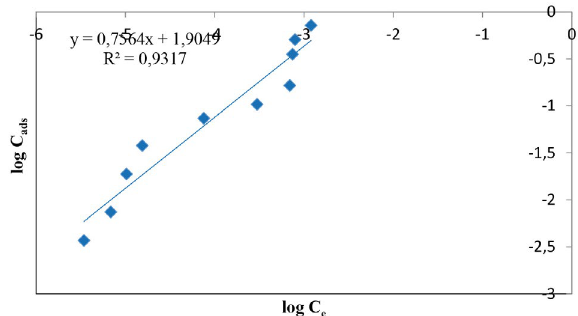
Figure 11. Freundlich isotherm for Cr(VI) sorption of onto isatin based Amberlite XAD-2